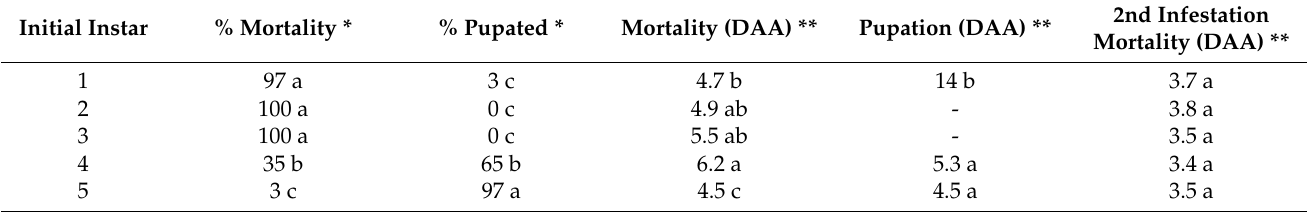
Lowercase letters denote a significantly different value within the sprayed or unsprayed treatments. * Denotes statistical analysis according to Fisher’s exact test ( α = 0.05). ** Denotes statistical analysis according to Tukey’s LSD ( α =